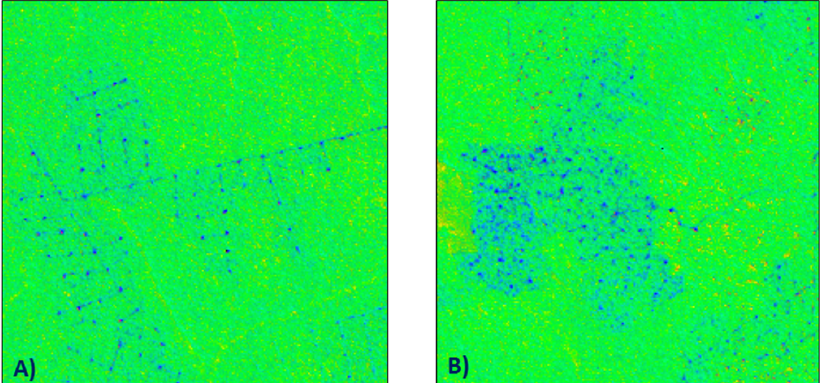
Figure 2. Extract of a spectral un-mixed Landsat image (30 m spatial resolution) illustrating two different patterns of forest disturbance (displayed in color composite Red Green Blue: Soil; Active Photosynthetic Vegetation; Non-photosynthetic Vegetation). ( A ) Illustrates a pattern of conventional logging with a symmetric spatial arrangement of the impacts organized around primary and secondary logging roads; ( B ) represents a pattern of illegal logging with an anarchical spatial organization and high damage in the canopy cover.